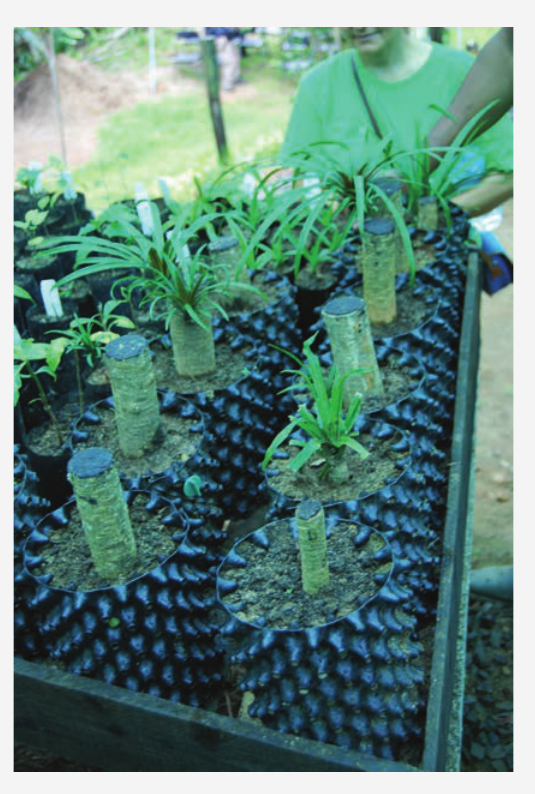
Figure 6. Dracaena umbraculifera being propagated from cuttings at Parc Ivoloina for ex situ conservation. Photo by Peter Wyse Jackson